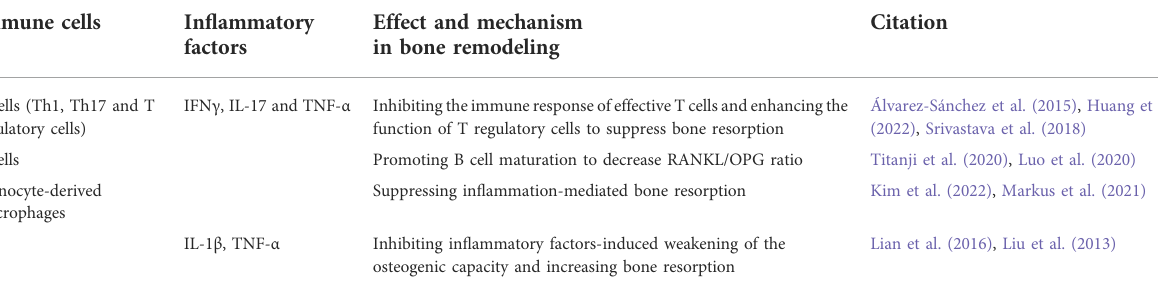
TABLE 4 Mechanism of melatonin-regulated immune cells and in fl ammatory factors involved in bone metabolism. Immune cells In fl